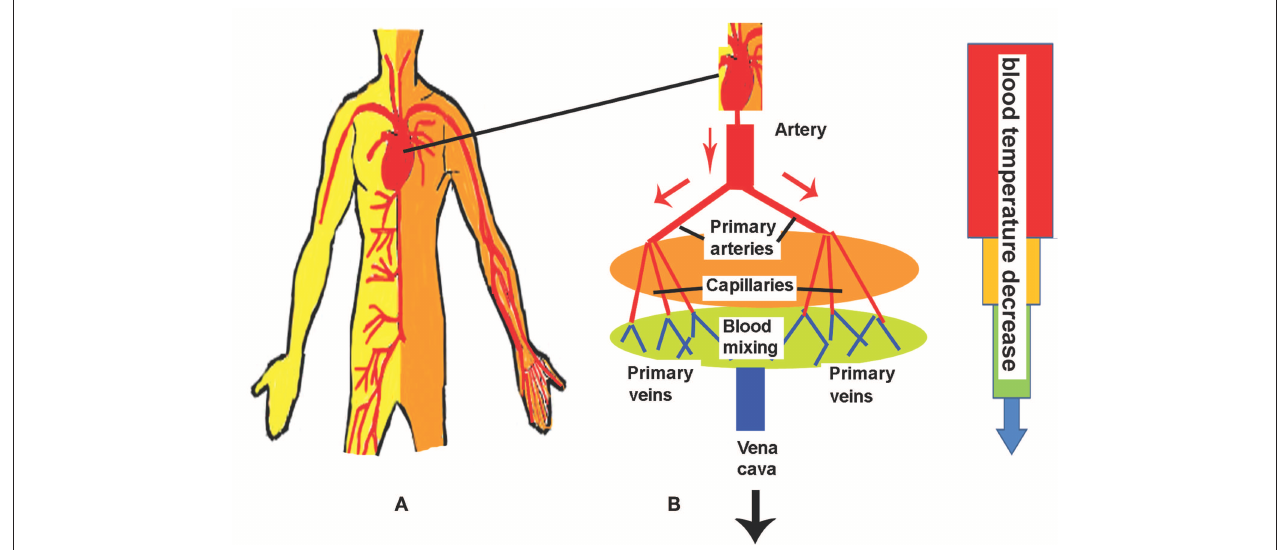
FIGURE 2 | Schematic presentations of human body circulatory system (A) and blood temperature distributions through the vessels of the circulatory system (B) . See comments in the